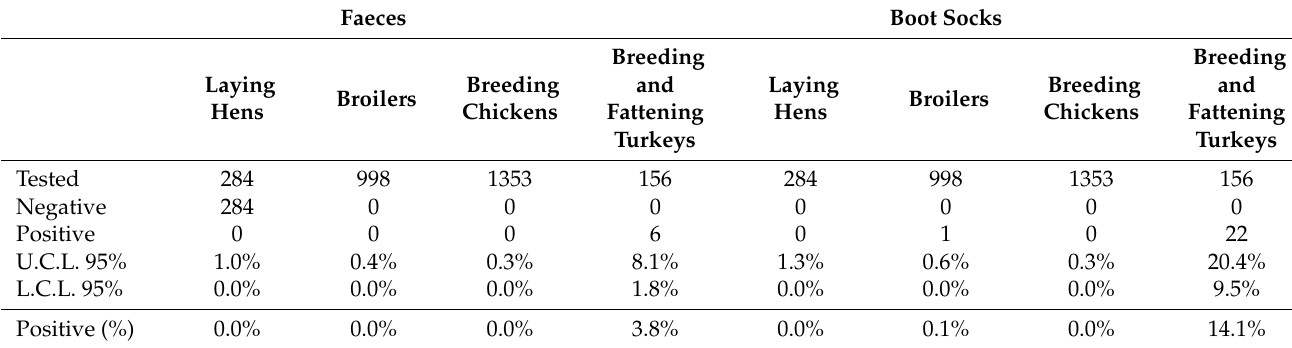
Table 5. Percentages of positive results, according to the matrix associated with its sampling method by flock category.